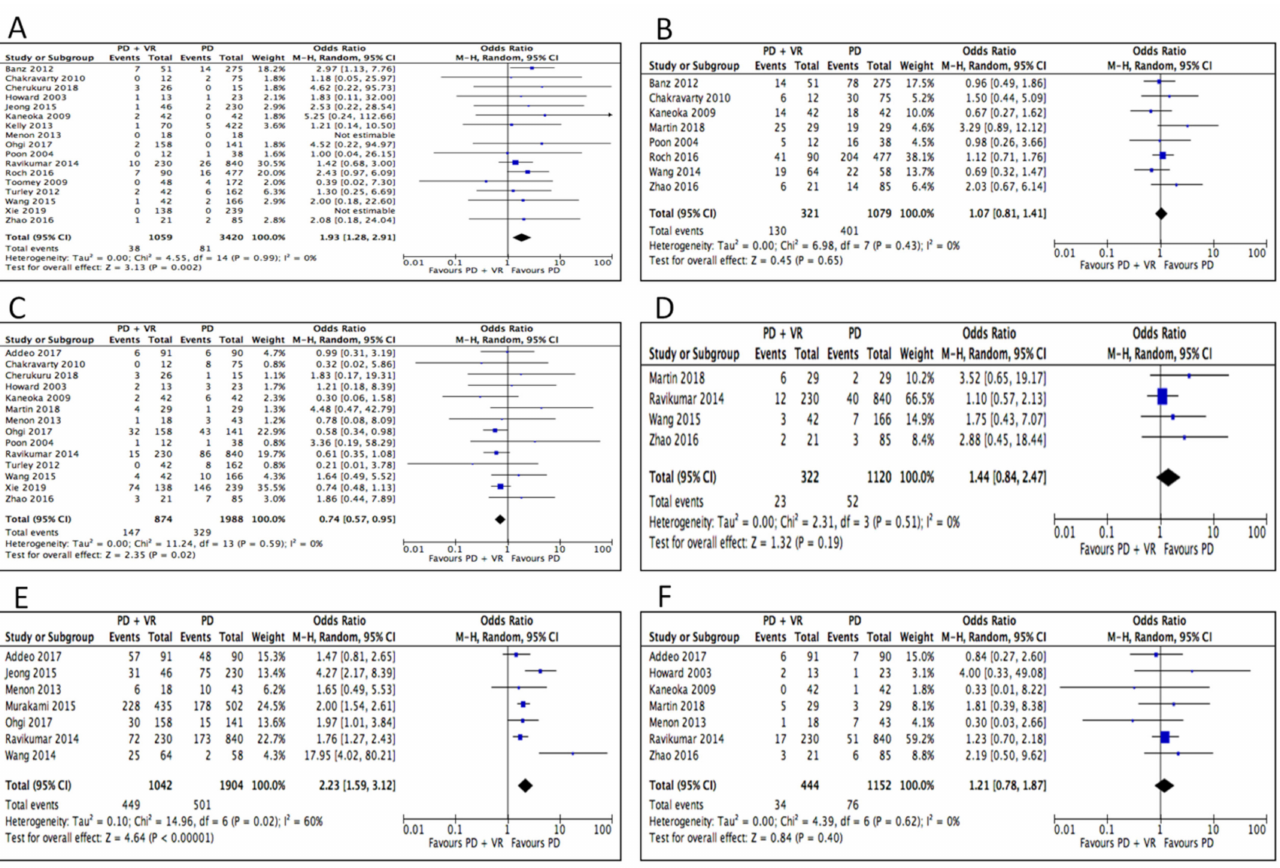
Figure 3. Meta-analysis of postoperative outcomes. ( A ) Mortality. ( B ) Overall complications. ( C ) Pancreatic fistula. ( D ) Hemorrage. ( E ) Transfusions. ( F )